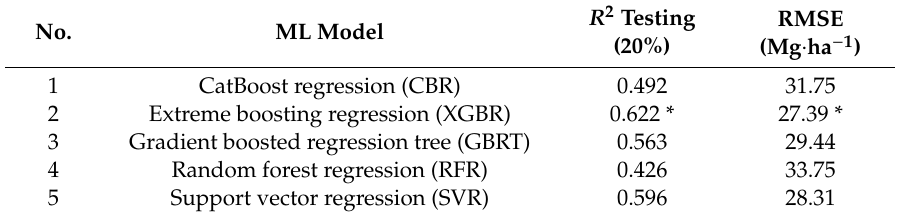
Table 6. ML technique performance using all the features for the mangrove AGB retrieval in this